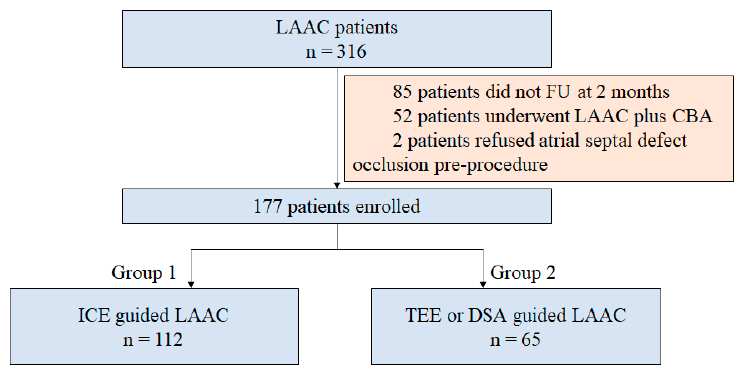
Figure 1. Study flowchart. LAAC = left atrial appendage closure; FU = follow-up; CBA = cryoballoon ablation; ICE = intracardiac echocardiography; TEE = transesophageal echocardiography; DSA = digital subtraction angiography.